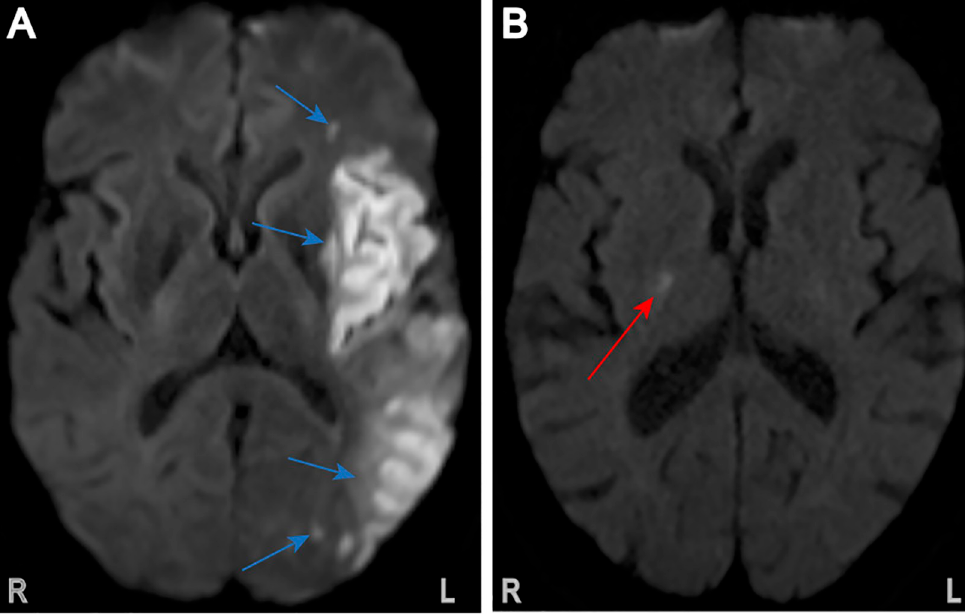
Fig 1. Sample patient brain magnetic resonance images demonstrating acute ischemic stroke patterns on T2 diffusion- weighted images. (A) Adjudicated cardioembolic stroke with multiple lesions (blue arrows) in left middle cerebral artery distribution. Total calculated infarct volume: 105.4mL. (B) Adjudicated small-vessel occlusion stroke with single lesion (red arrow) in the posterior limb of the right internal capsule. Total calculated infarct volume: 0.194mL.